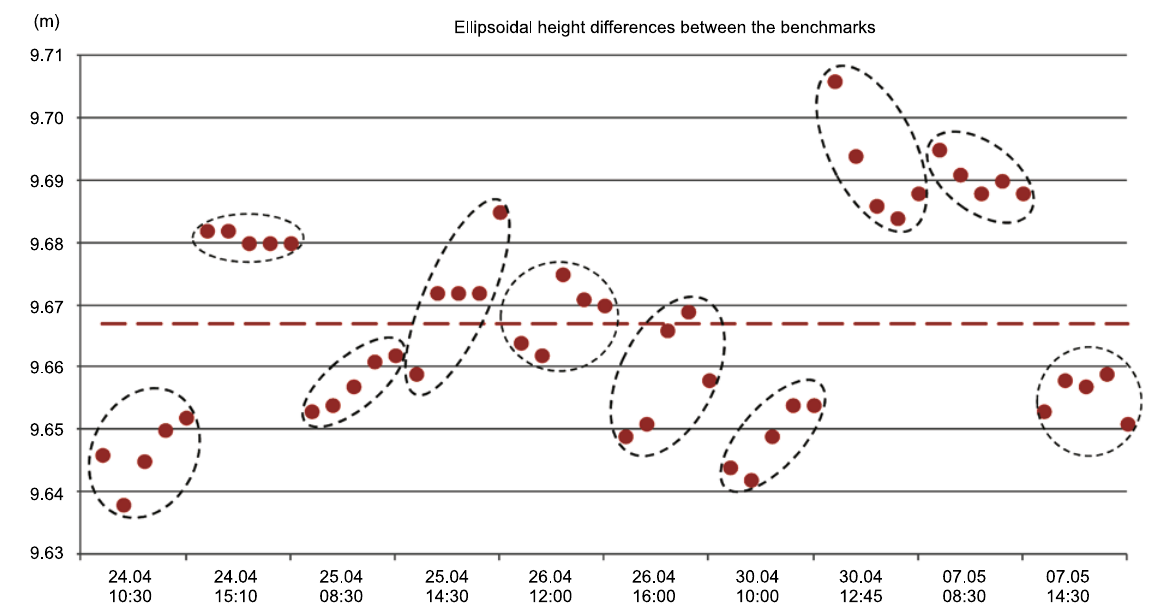
Fig. 5. Ellipsoidal height differences (VRS) between the benchmarks (data of each session enclosed with dotted ellipses)